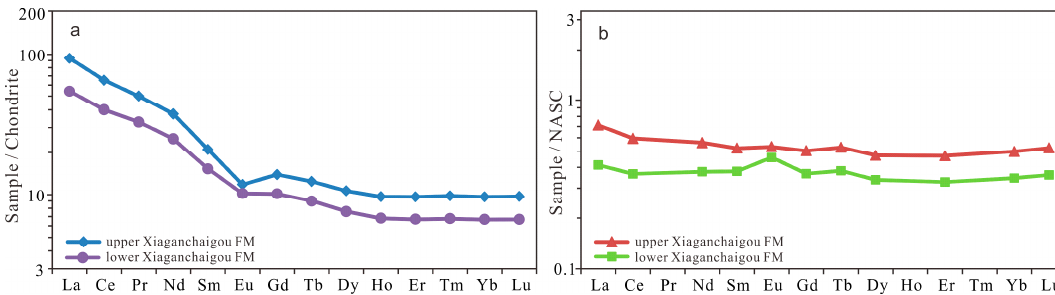
Figure 7. Chondrite-normalized rare earth element (REE) patterns ( a ) and NASC (North American